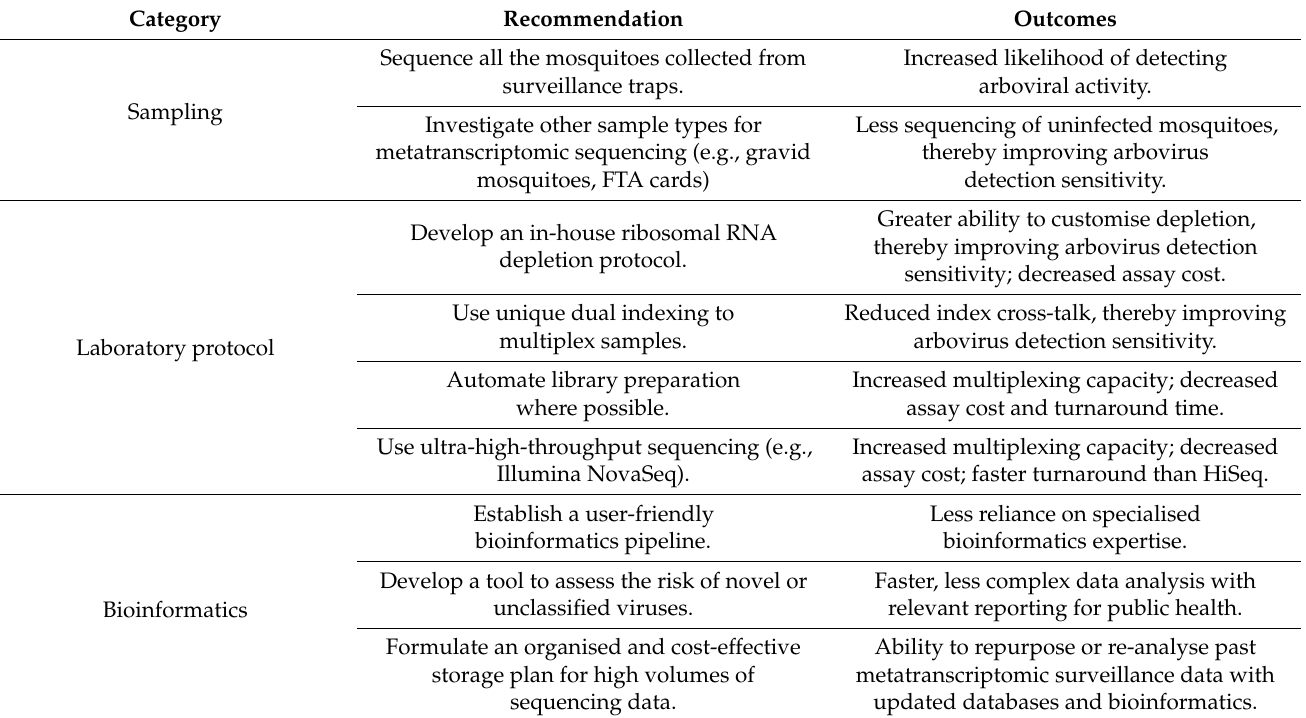
Table 1. Recommendations for the incorporation of metatranscriptomics in routine arbovirus surveil- lance